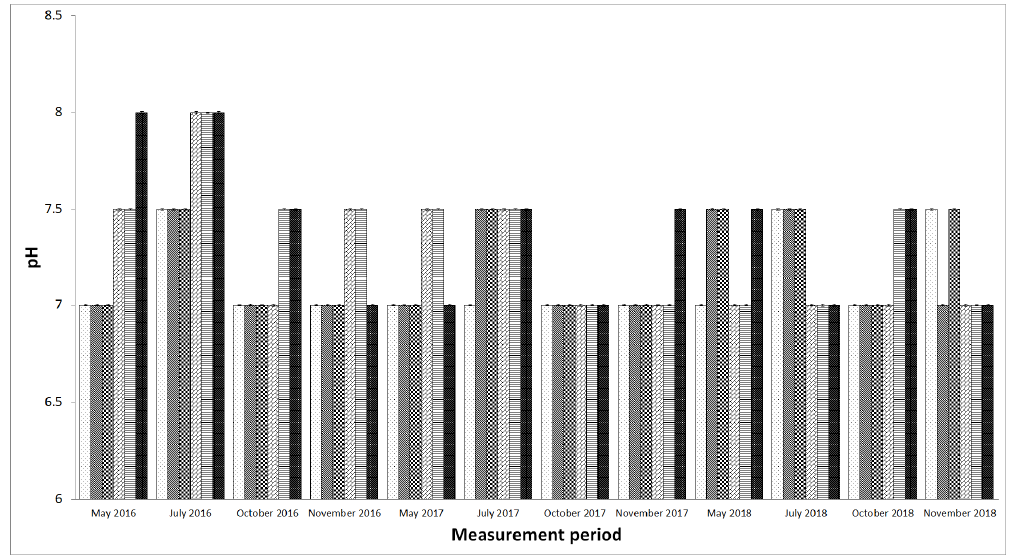
Figure 3. In the pH value at points P1–P6 in the reservoir. Measurement campaigns 2016–2018. Table 2. The schedule of laboratory indication and in situ measurement during measurement campaigns.